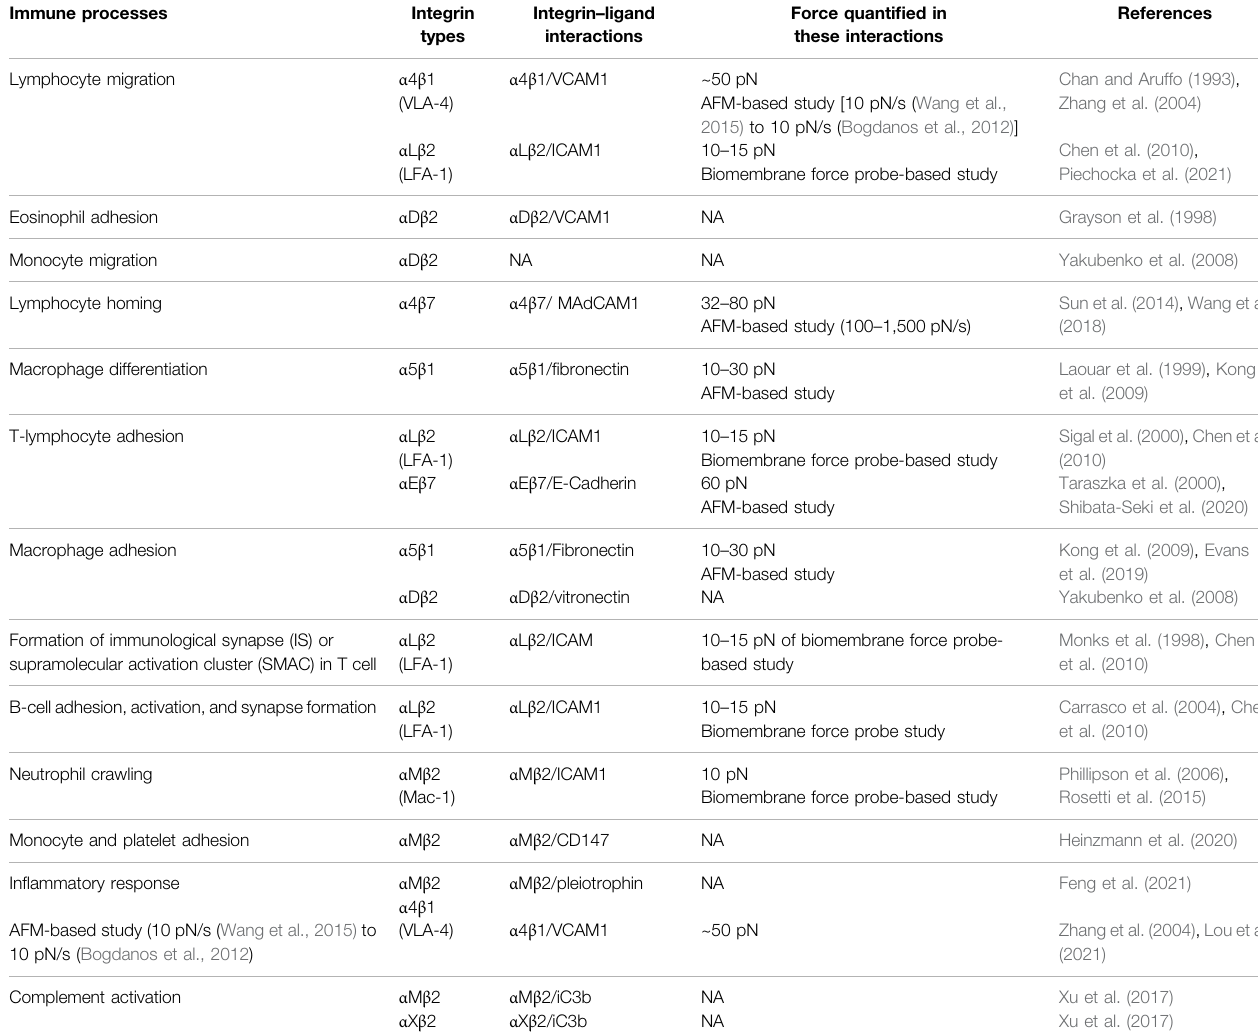
TABLE 2 | Integrin – ligand interaction playing regulatory roles in immune cells